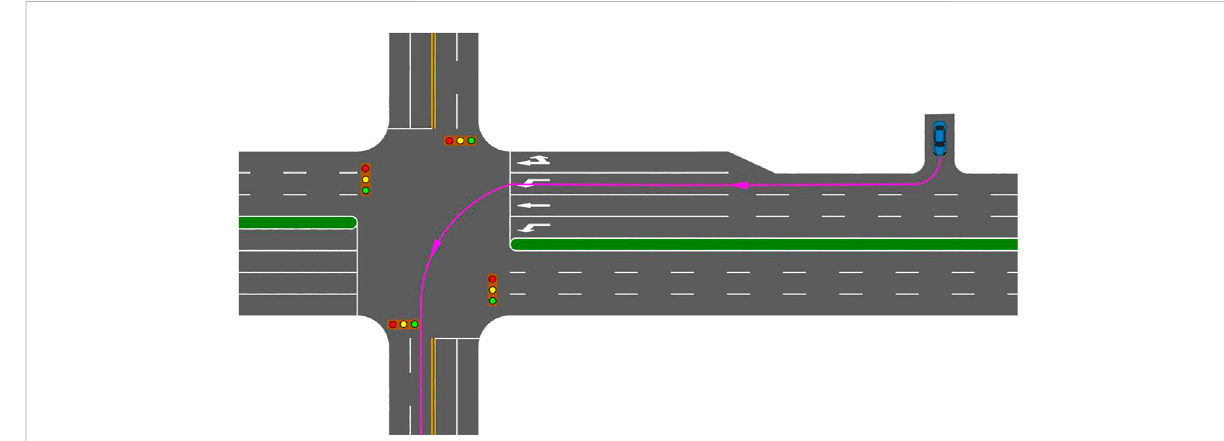
FIGURE 1 Unconventional outside left-turn lane design at signalized intersections.